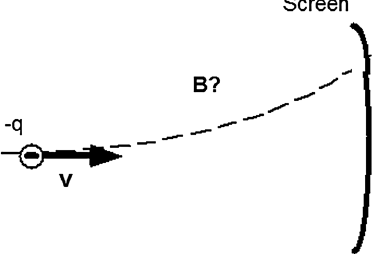
FIG. 6. Diagram provided for Q22 on the